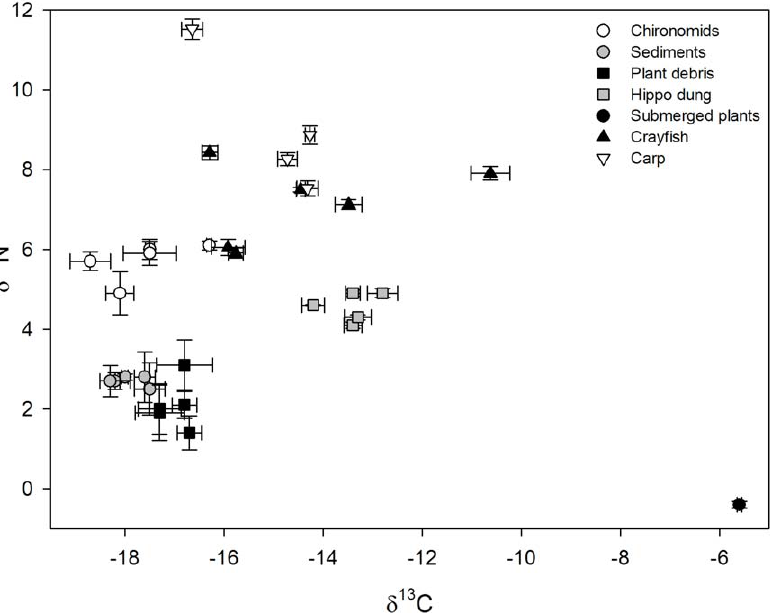
Figure 2. Stable isotope bi-plot showing the intra- and inter-annual variation in isotope values of resources, carp and crayfish. Each data point represents an annual mean and the error bars represent the intra-annual standard error.